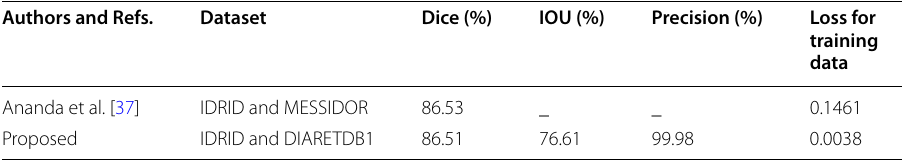
Table 3 Comparison of the results of the proposed method for retinal hemorrhage segmentation to the latest current methods in terms of similarity coefficient (Dice), intersection over union (IoU), precision and loss for training data Authors and